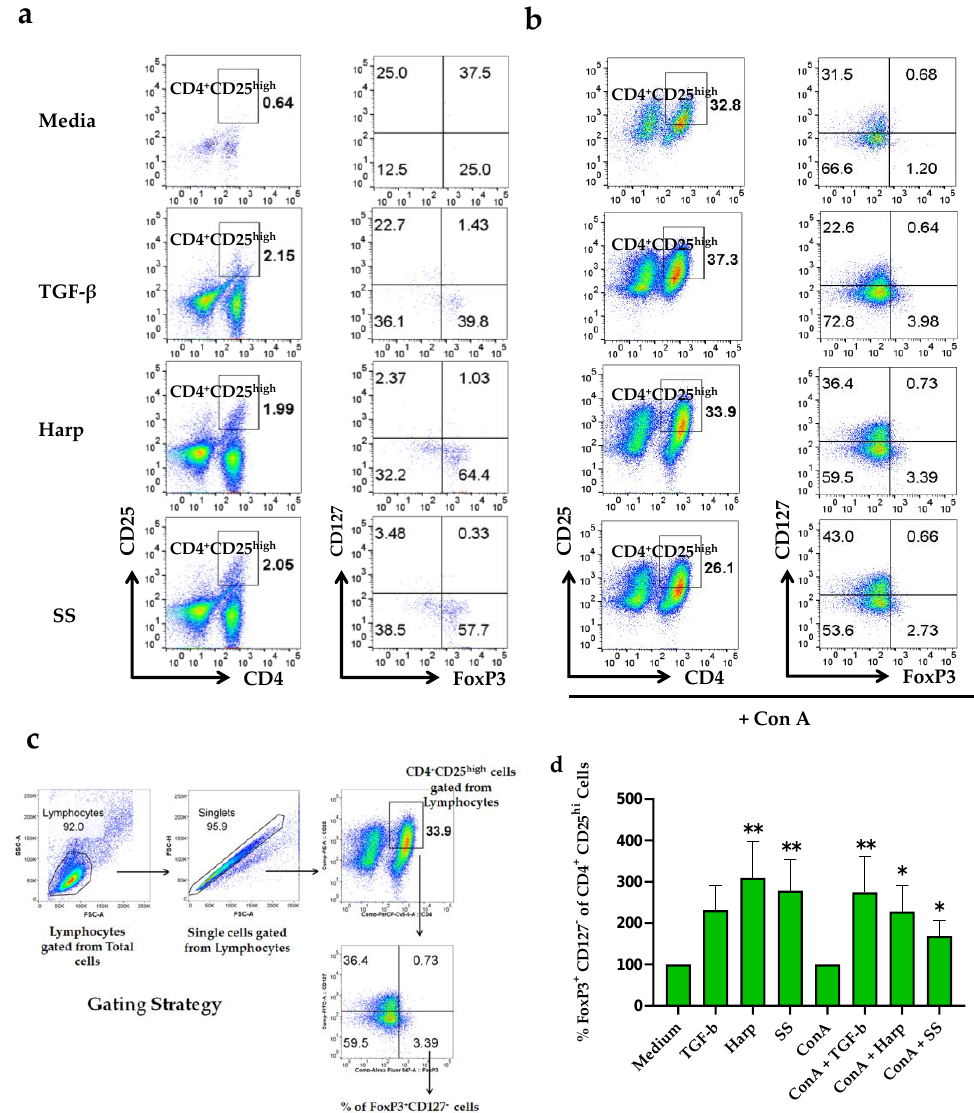
Figure 3. Flow cytometric analysis for the CD4 + CD25 hi FoxP3 + CD127 − T cells. Human peripheral blood mononuclear cells were isolated and incubated in the presence or absence of 5 μg/mL ConA along with either 10 ng/mL TGF-β, 1 μM Harp or 5 μM SS for 5 days. ( a ) Effect of treatment with compounds in the absence of ConA; and ( b ) in the presence of ConA. ( c ) The gating strategy for CD4 + CD25 hi FoxP3 + CD127 − T cells. ( d ) Percentages of FoxP3 + CD127 − CD4 + CD25 hi T cells following various treatments, showing average of triplicate and calculated as % of total lymphocytes ± S.E. Statistically significant difference when % is compared with medium alone in non-activated cells or with ConA-activated PBMCs for the ConA-activated cells (* p < 0.05 and ** p < 0.005). The data shown in ( d ) represent two biological replicates.